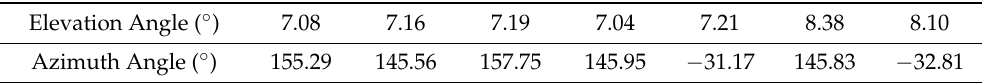
Table 3. DOA estimation by UCMA-ESPRIT for outer race fault signal at 290 rpm. Elevation Angle ( ◦ )